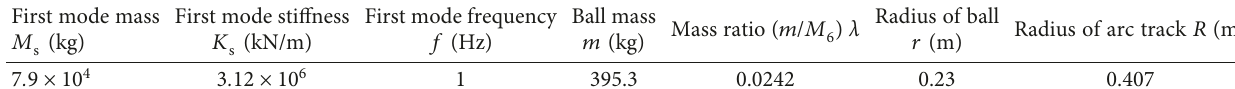
Table 3: Model parameters of a PTRMD-controlled MDOF structure.